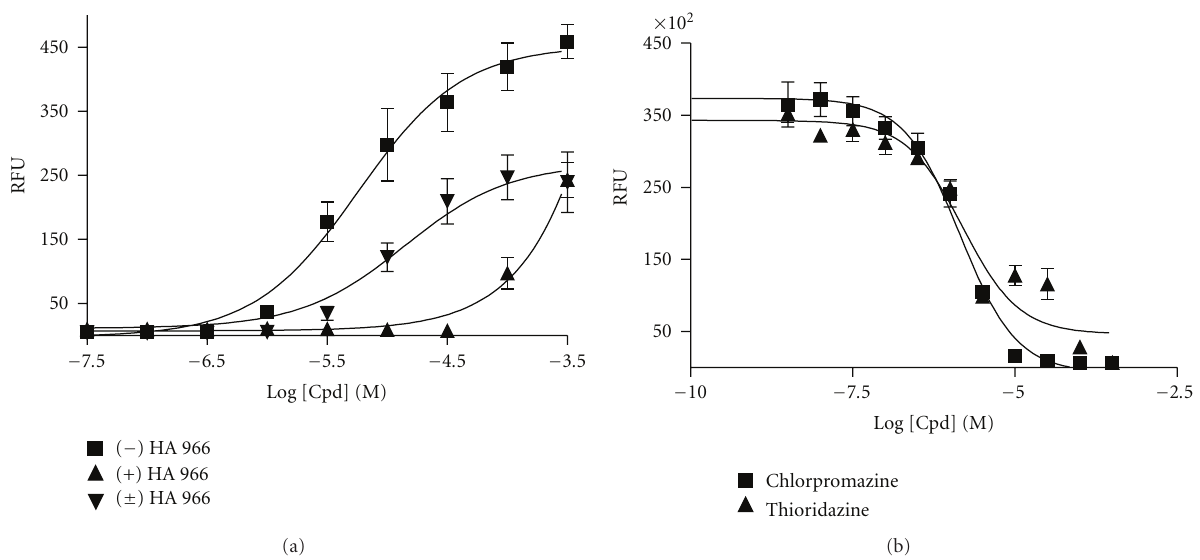
Figure 5: Illustration of the dose-response curve of selected agonists and antagonists. An agonist identified, ( ± ) HA 966, is a racemic mixture, and further characterization of the positive and negative enantiomers showed that the latter was the most potent MrgD agonist among all three (Figure 4(a)). The EC 50 values were 11, 106, and 5.5 μ M for the racemic mixture, positive, and negative isoforms of the compound, respectively. Figure 4(b) shows two representative MrgD antagonists thioridazine and chlorpromazine, with IC 50 values of 1.5 and 2.7 μ M,